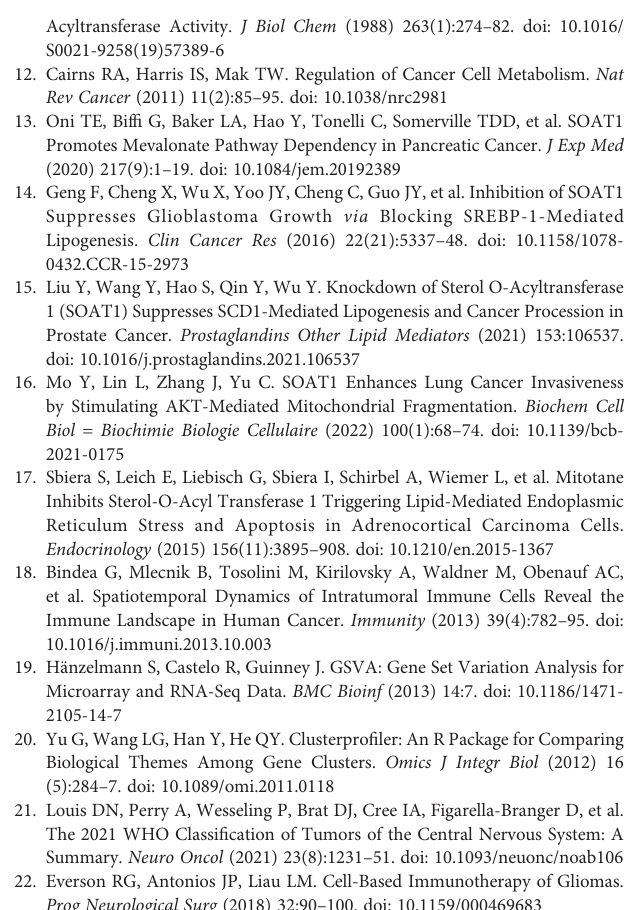
Supplementary Figure 1 | (A – S) Correlation between SOAT1 expression and immune in fi ltrating cells in GBM based on TISIDB dataset. SOAT1, sterol O- acyltransferase 1 ; GBM, glioblastoma; TISIDB, an integrated repository portal for tumor-immune system interactions. Supplementary Figure 2 | (A – R) Correlation between SOAT1 expression and immune in fi ltrating cells in LGG based on TISIDB dataset. SOAT1, sterol O- acyltransferase 1 ; LGG, lower grade glioma; TISIDB, an integrated repository portal for tumor-immune system interactions. Supplementary Figure3 | (A) GO enrichment analysis of SOAT1 in gliomabased on the TCGA cohort. (B) Chordal graph of signi fi cantly enriched BP of SOAT1 in glioma by GO analysis based on TCGA cohort. GO:0006958 complement activation, classical pathway. GO:0002455humoral immune response mediated by circulating immunoglobulin. GO:0006956 complement activation. GO:0006959 humoral immune response. GO, Gene Ontology; SOAT1, sterol O-acyltransferase 1 ; TCGA, The Cancer Genome Atlas; BP, biological processes. Supplementary Figure 4 | (A) Chordal graph of signi fi cantly enriched MF and CC of SOAT1 in glioma by GO analysis based on TCGA cohort. GO:0019814 immunoglobulin complex, GO:0042571 immunoglobulin complex circulating, GO:0003823 antigen binding, GO:0034987 immunoglobulin receptor binding. MF, molecular functions; CC, cellular component; SOAT1, sterol O-acyltransferase 1 ; GO, Gene Ontology; TCGA, The Cancer Genome Atlas. Supplementary Figure 5 | (A – F) K-M curves of each type of glioma based on WHO 2021 classi fi cation of brain tumors in the TCGA cohort. K-M, Kaplan-Meier; WHO, World Health Organization; TCGA, The Cancer Genome